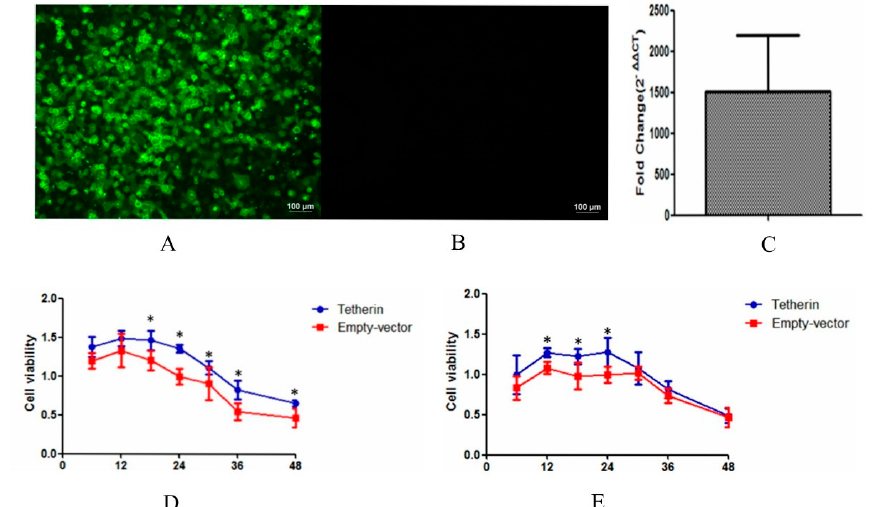
Figure 7. MDCK cells stably expressing tetherin protein were generated and the levels of tetherin expression and cell viability after CIV infection were assessed at different time points. ( A ) The expression product of canine tetherin was detected through IFA in cells stably expressing tetherin;